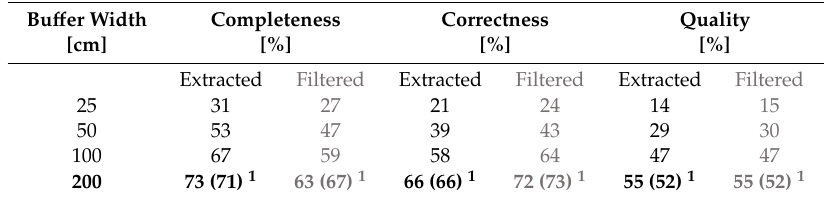
Table 5. Accuracy assessment of boundary extractions for a GSD of 100 cm, scale 80, merge 95.